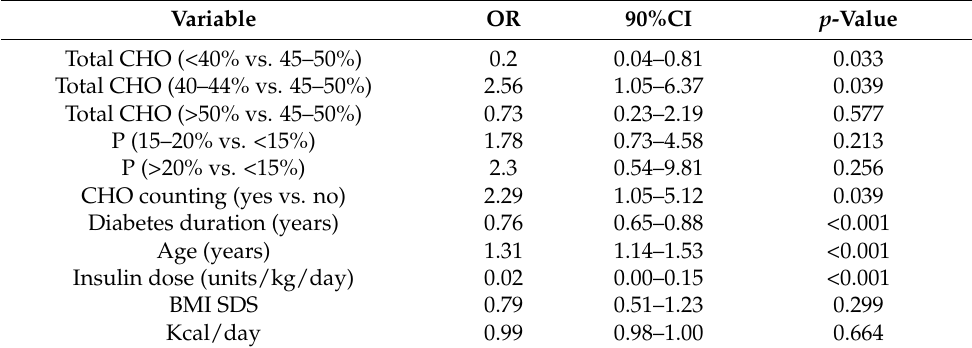
Table 3. Factors associated with target TIR